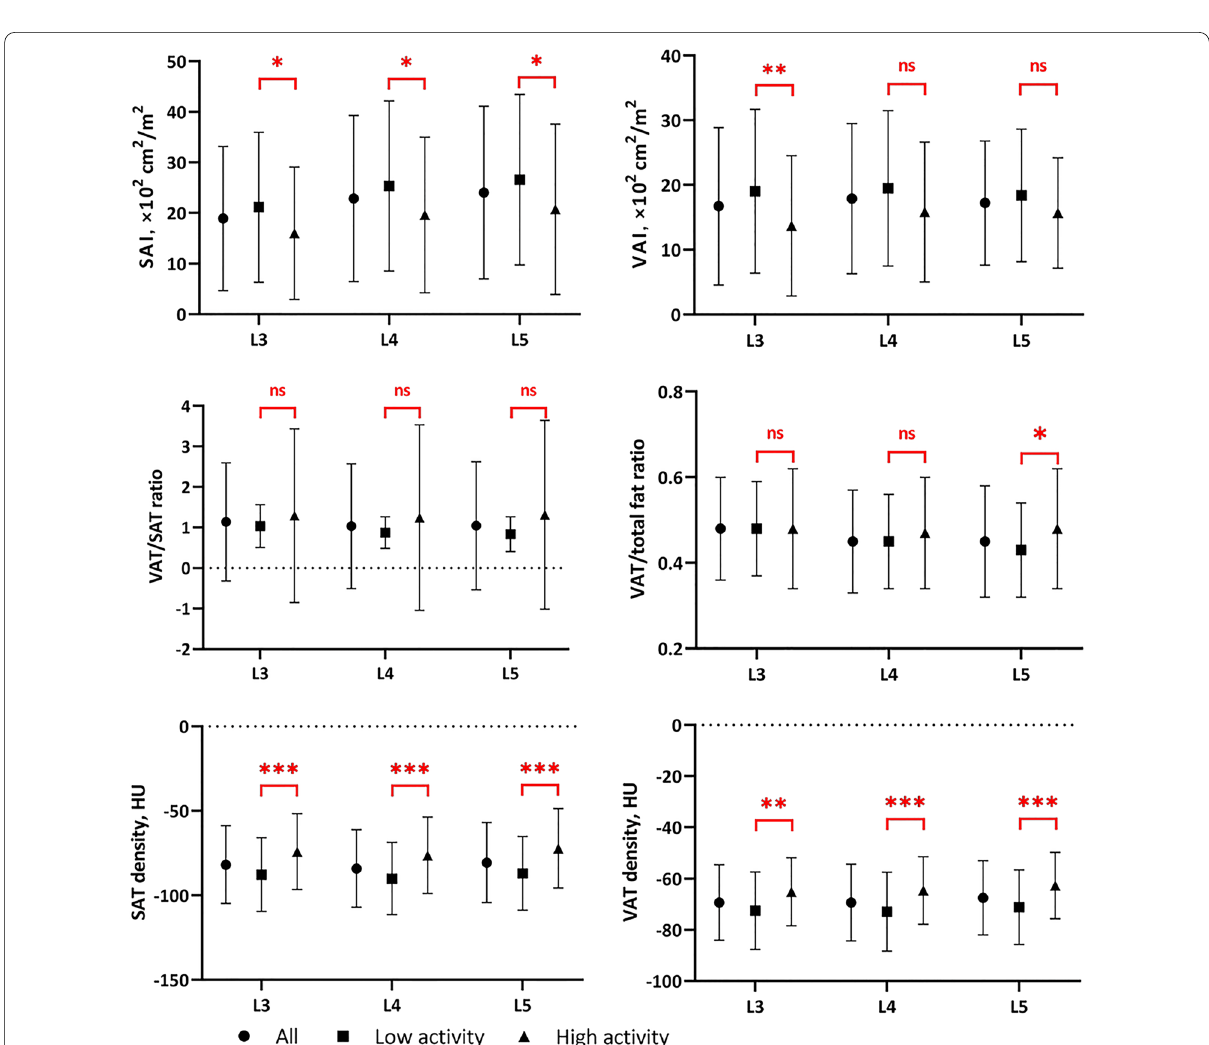
Fig. 3 Comparison of CT body composition parameters between low and high activity groups. The first row shows the comparison of SAI and VAI between the two groups, where differences in SAI were observed from L3 to L5 ( p 0.015, 0.019, and 0.017, respectively), while differences = in VAI were only significant at the L3 level ( p 0.008); the second row shows a comparison of the relative content of VAT, where the VSR was not = statistically different between the two groups, but we observed a difference in the VA/TA index at the L5 level ( p 0.04); the third row shows the = comparison between SAT and VAT density, the results showed significant differences in SAT and VAT density between the two groups at all three levels. ns, no significant; * p < 0.05; ** p < 0.01; *** p < 0.001. SAT, subcutaneous adipose tissue; VAT, visceral adipose tissue; SAI, subcutaneous adipose